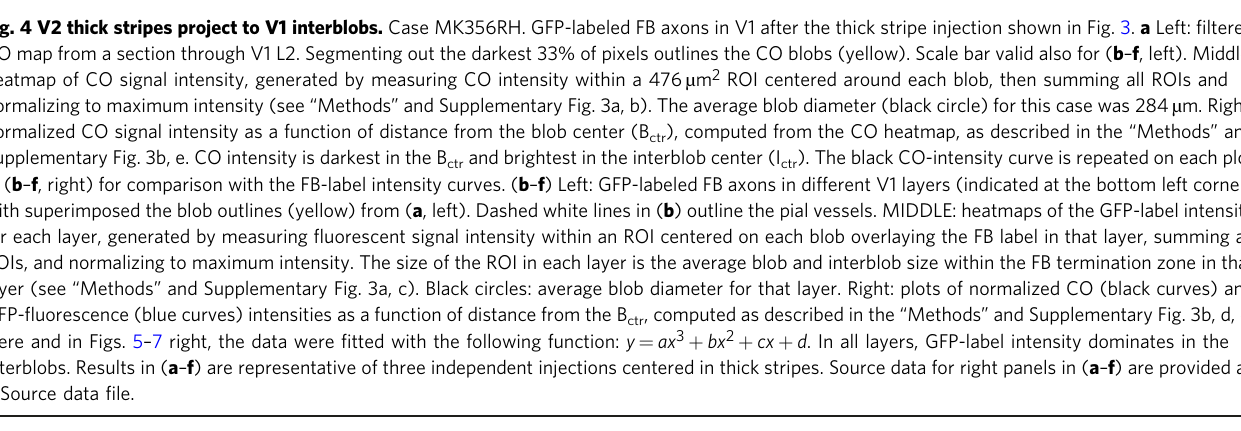
Population analysis . Figure 7 shows the summary data (see “ Methods ” ) for the population of injections, grouped by stripe